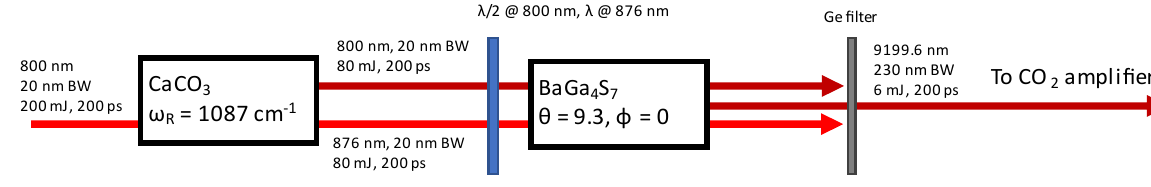
Fig. 2 . Proposed seed generation scheme. A stretched 800 nm TiS laser pulse pumps a Calcite crystal to generate an 876 nm seed by stimulated Raman scattering. Polarization state of two NIR pulses is adjusted by a dual-wavelength waveplate. LWIR pulse is produced via type-I difference frequency generation in BGS and separated from the NIR pump by a Ge filter.